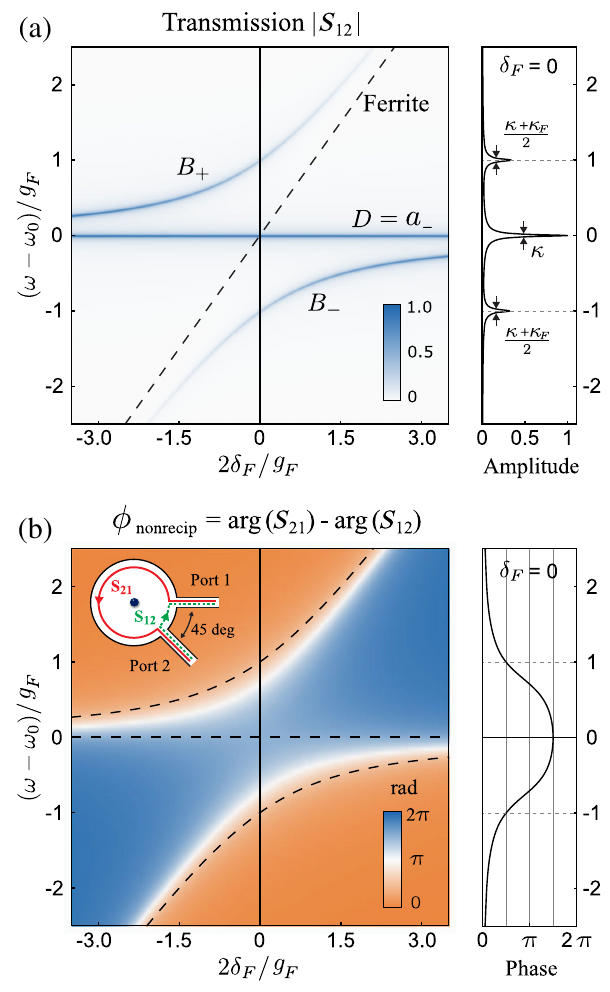
FIG. 2. Response of a ferrite-cavity site described by H ð F Þ in a is the response between a port pump-probe experiment. Here, S ij i ¼ 1 located at the ˆ x axis and a second port j ¼ 2 measured 45° away [inset of (b)]. In order to account for loss, we introduce a for the microwave cavity and ferrite, respec- linewidth κ and κ F =g < 10 − 2 , this tively. For physically relevant values of κ =g , κ F F F = κκ > 10 4 . (a) Am- gives a corresponding cooperativity η ¼ 4 g 2 F F plitude of the transmission response j S 12 j . The chirality of a ferrite in a magnetic field allows it to couple only to the resonator mode of the same handedness, producing an avoided crossing in the transmission spectrum as the ferrite is tuned through resonance with the resonator modes. This avoided crossing appears as two and B − . The dark mode modes that are bright to the ferrite, B þ D ¼ a − doesnotcoupletotheferrite,andisthereforeunshiftedand insensitive to ferrite loss κ . (b) The nonreciprocal phase, F ϕ arg ð S 21 Þ − arg ð S 12 Þ , reflects the phase difference be- nonrecip ¼ tween going in the 0° port and out the 45° port, and the reverse 3 π = 2 for the dark mode. This process. This is ideally ϕ nonrecip ¼ time-reversal break is robust to detuning in either the ferrite or the probe, and also loss, with the lowest-order correction entering ≈ ð 3 π = 2 Þ − 2 ½ δ δ − 2 δ =g 2 as ϕ (cid:3) − ð 2 = η Þ . (c) A slice p ð p F Þ nonrecip F through the nonreciprocal phase as a function of the probe detuning, for the ferrite tuned to resonance. The nonreciprocal ≈ 3 π = 2 is apparent near the dark phase of ϕ nonrecip